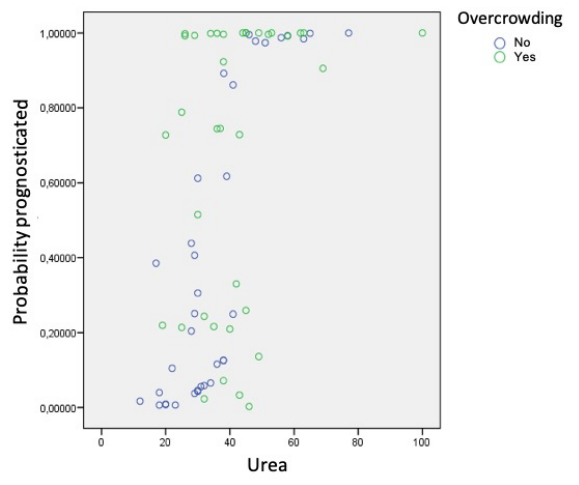
Figure 7. Relation between phosphorus levels and dental crowding.